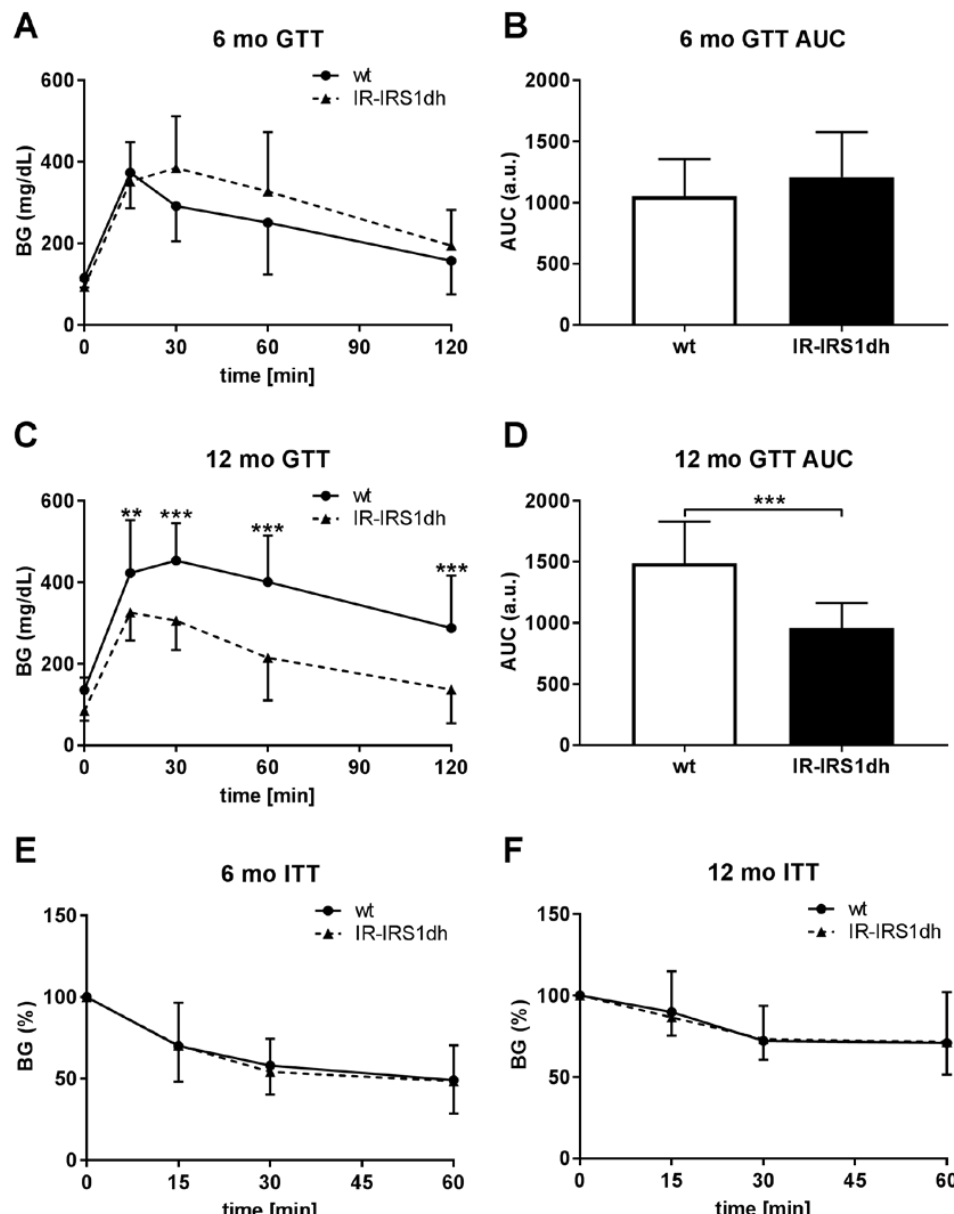
Figure 1. Glucose and insulin tolerance of IR-IRS1dh mice. ( A , C ) Blood glucose (BG) levels during intraperitoneal glucose tolerance tests (GTT) and ( B , D ) area under the curve (AUC) of GTT results. ( E , F ) Blood glucose levels during insulin tolerance tests (ITT) normalized to 0 min blood glucose levels (100%). Columns and symbols represent mean values ± standard deviation; ( A – D ) n : 11–24, ( E , F ) n : 5–13; * denotes significant differences between IR-IRS1dh mice compared to wt controls; ** p < 0.01, *** p < 0.001.